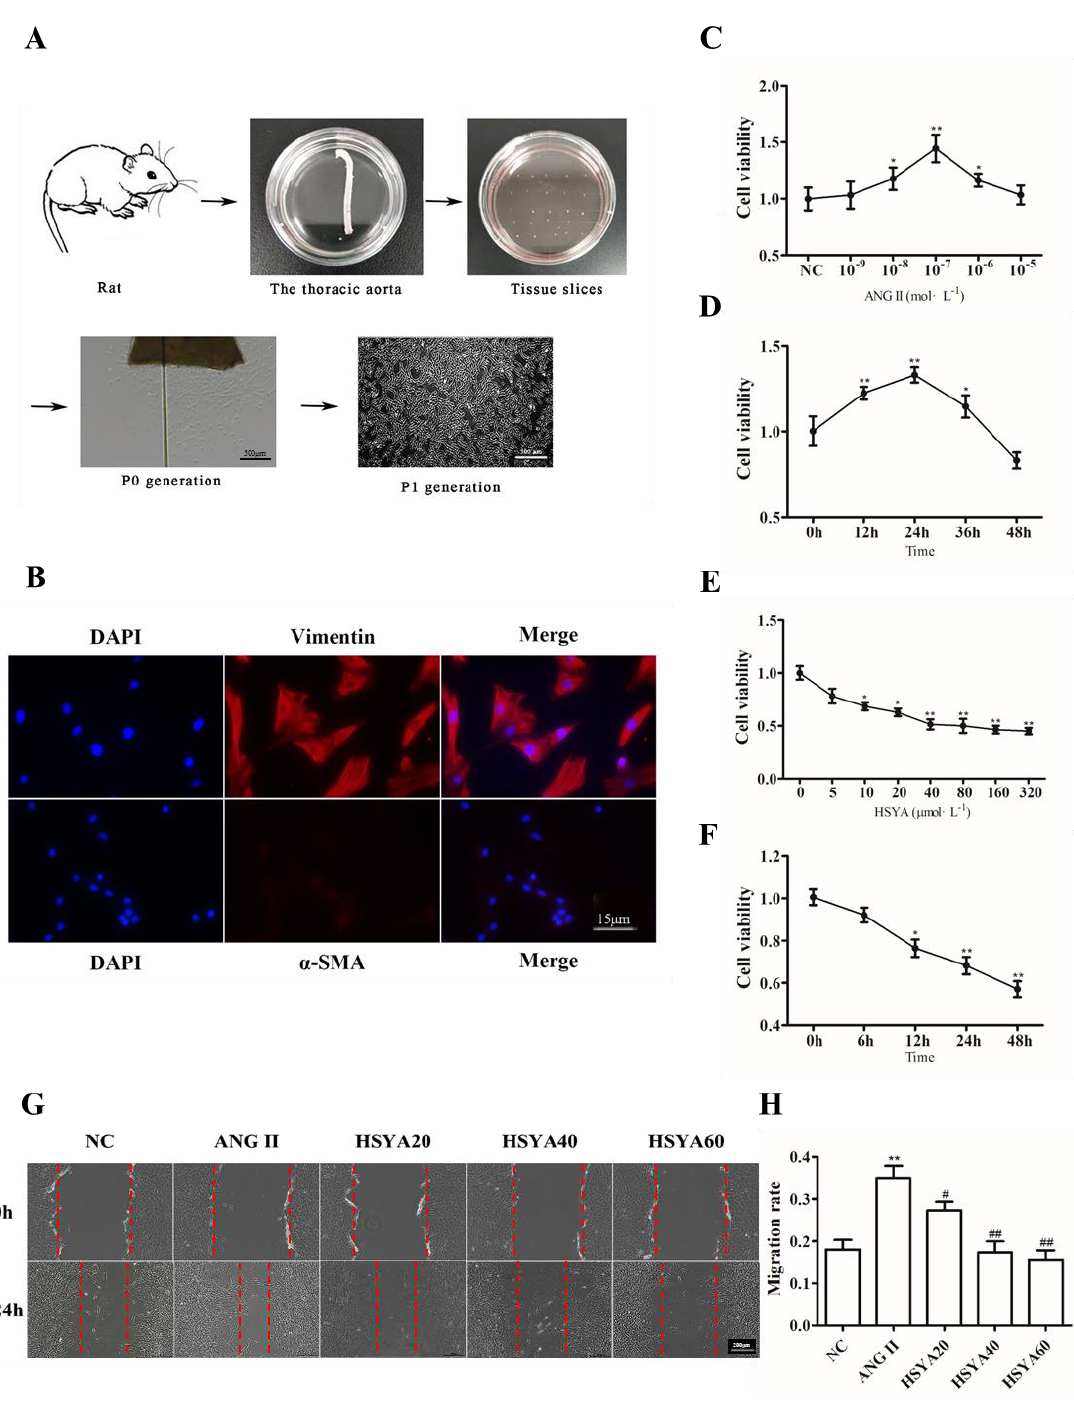
Figure 1. HSYA inhibits angiotensin II-induced VAF migration. ( A ) The primary culture protocol of VAFs. Scale bar, 500 µm. ( B ) Expressions of α -SMA and vimentin on VAFs separated from the adventitia of blood vessels ( n = 3). Scale bar, 15 µm. Red represents vimentin or α -SMA; blue represents